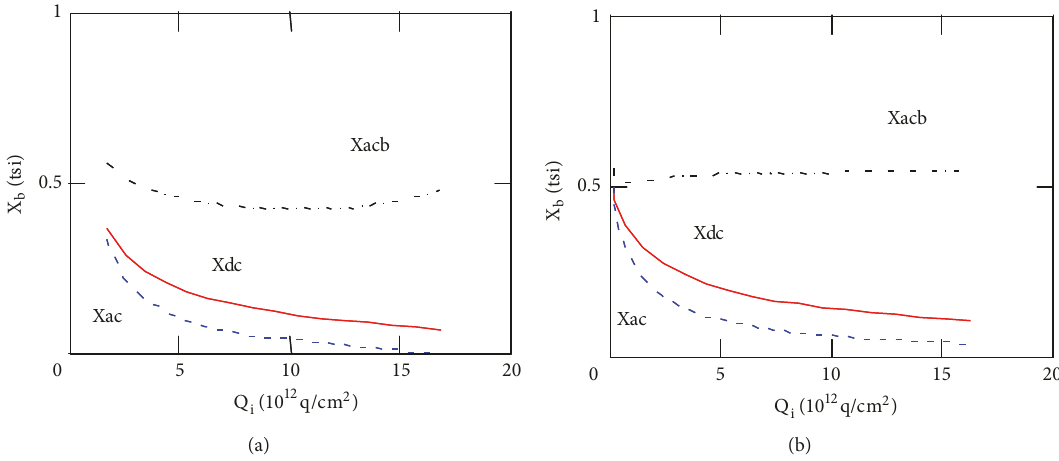
Figure 3: Variations of X